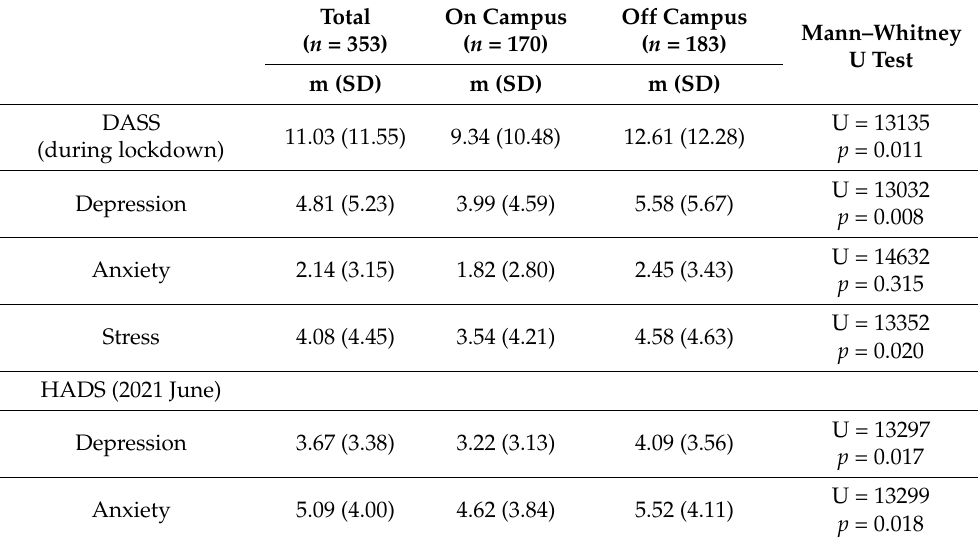
Table 3. Comparison of student anxiety and depression depending on residential status and period ( n =